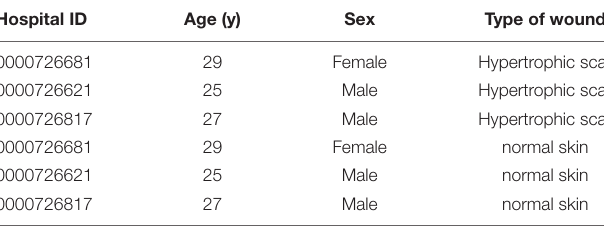
TABLE 1 | Clinical characteristics of patients.